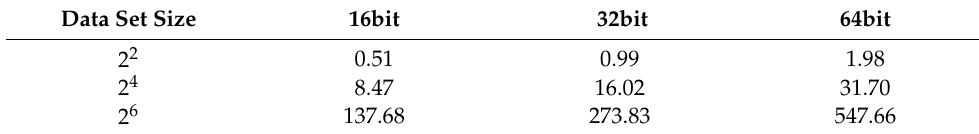
Table 8. Cloud computing time